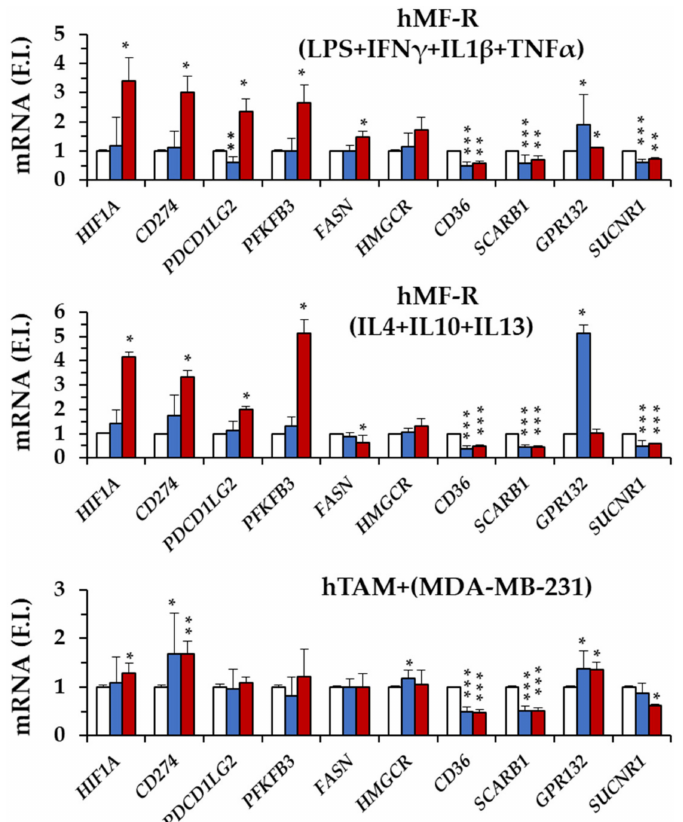
Figure 7. hMF di ff erential gene expression patterns in naïve and polarized cells after 24 h of treatment with TRB and LUR. hMF-RNAs from healthy donors were isolated and underwent RT. cDNA were obtained and 3 pools of the same amount of cDNA were prepared. Each cDNA pool consisted of 4 donors. Treatments: M1: LPS (100 ng / mL) + IFN γ + IL1 β + TNF α (20 ng / mL, each); M2: IL4 + IL-10 + IL13 (20 ng / mL, each); hTAM: hMF + MDA supernatants 24 h prior to the experiment. Results show the means + S.E.M. of fold induction (F.I.) from 8 to 12 di ff erent healthy donors assayed per triplicate. * p < 0.05; ** p < 0.01; *** p < 0.001 vs. the vehicle (Veh.)